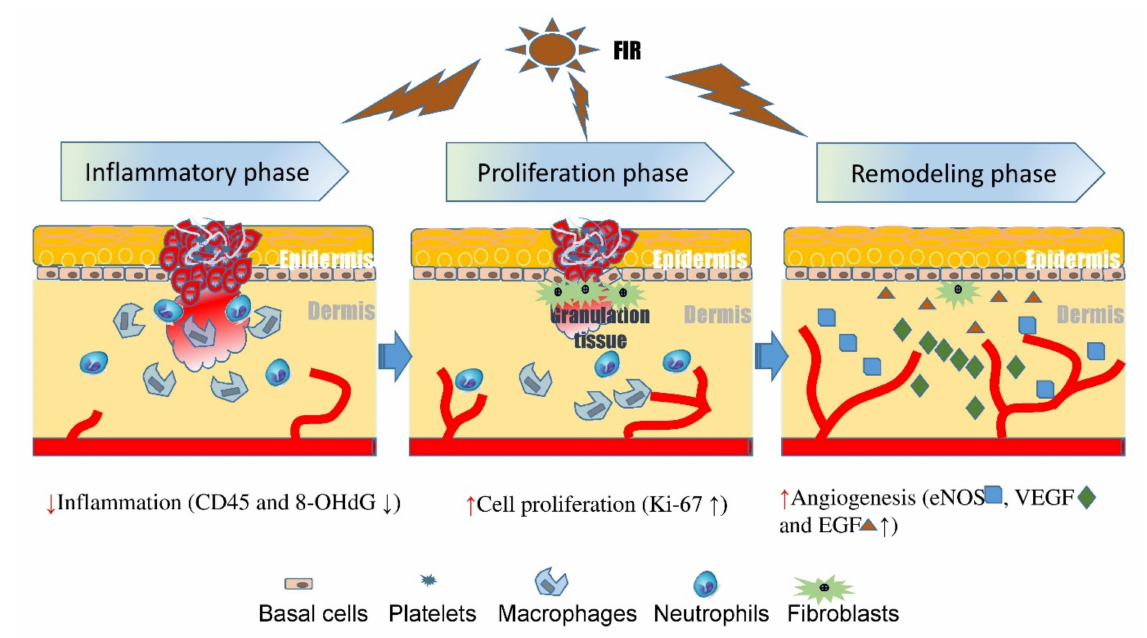
Figure 7. Proposed the biomechanisms of far-infrared radiation (FIR) treatment suppress the leukocyte infiltration, de- creasing inflammatory response (e.g., CD45+, 8-OHdG), enhancing cellular proliferation (e.g., Ki-67+ cells) and angiogenic factors (e.g., eNOS, VEGF, EGF), resulting in inducing epithelialization and wound